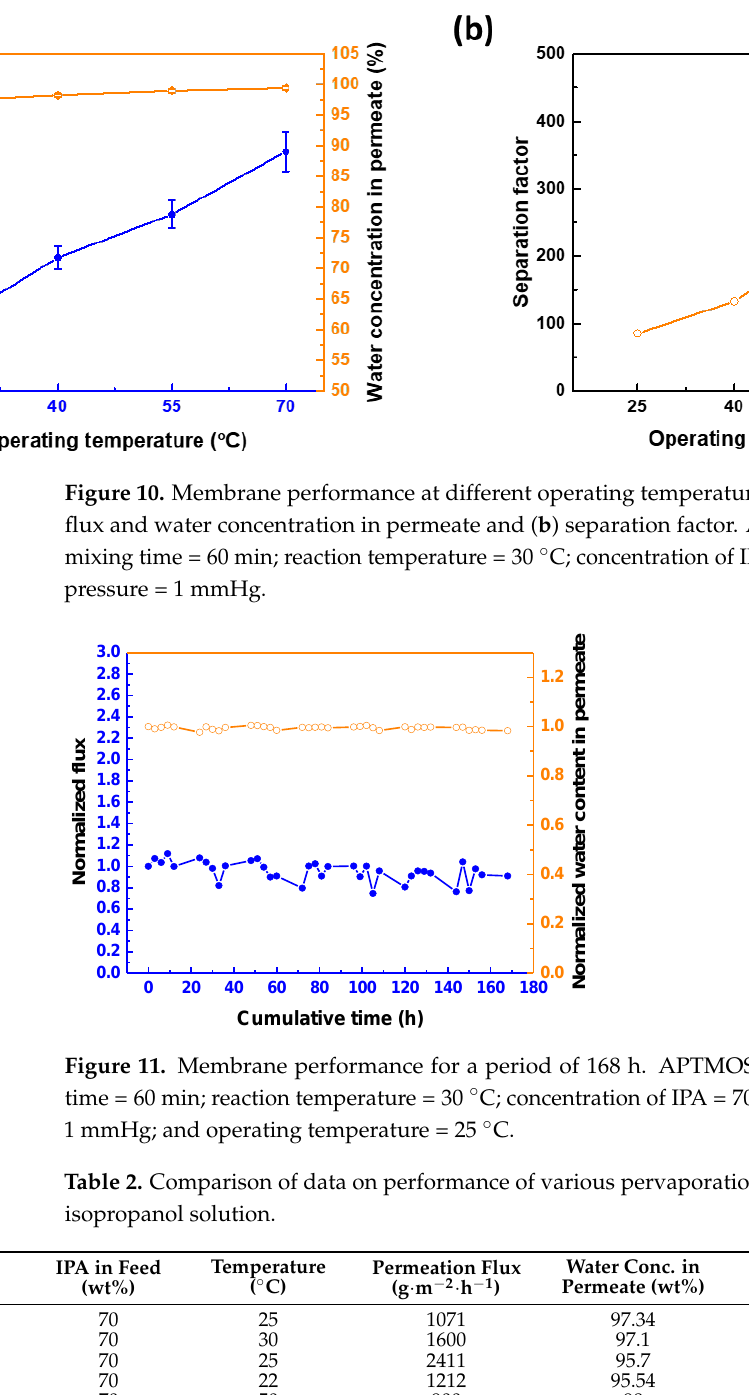
Figure 10. Membrane performance at different operating temperatures, in terms of ( a ) permeation flux and water concentration in permeate and ( b ) separation factor. APTMOS/CHDA ratio = 0.15; mixing time = 60 min; reaction temperature = 30 °C; concentration of IPA = 70 wt%; and downstream pressure = 1 mmHg.